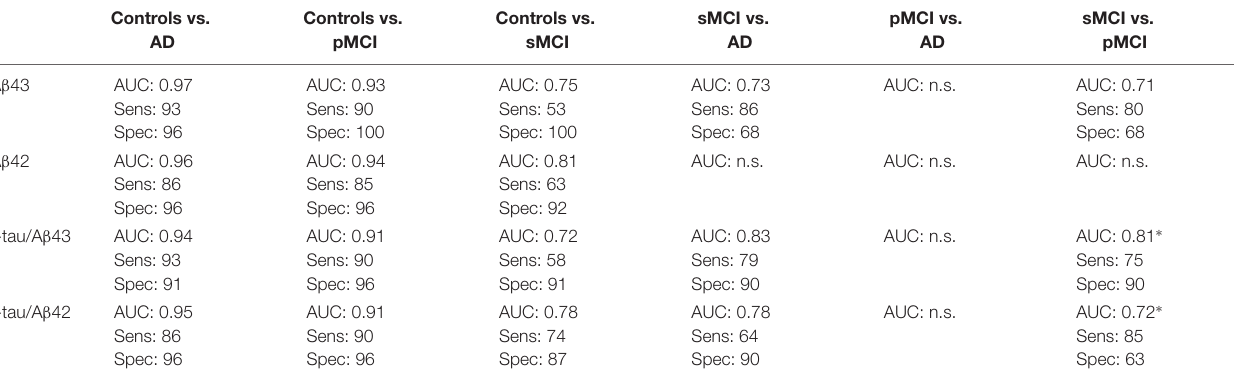
TABLE 3 | Diagnostic accuracy of CSF biomarkers at baseline. Controls vs.